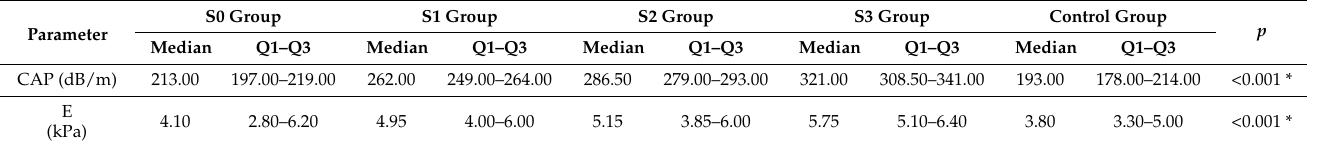
Table 2. Characteristics of the parameters of the elastography examination (FibroScan) of all groups.